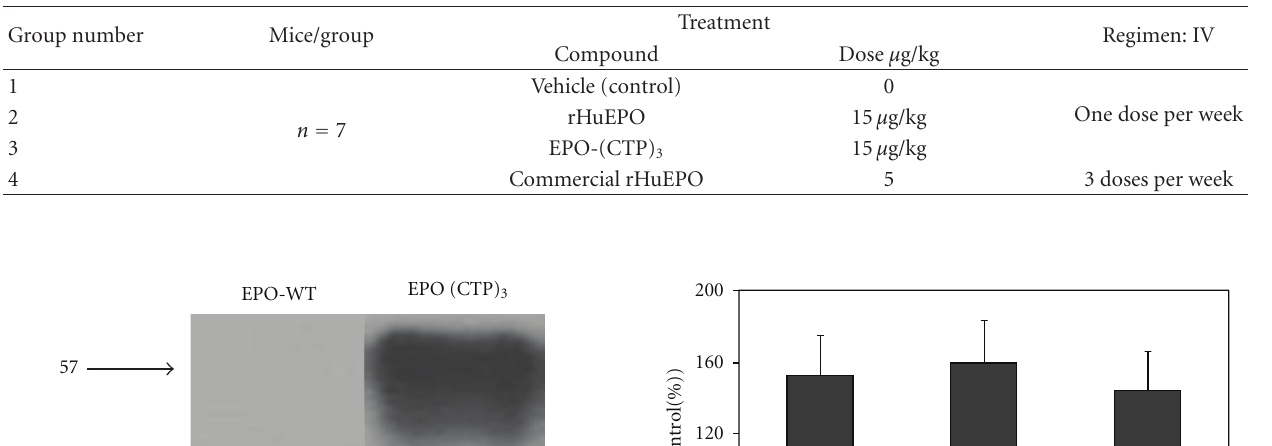
Table 1: Comparative 3 week induction of haematocrit by EPO-(CTP) 3 and rHuEPO.